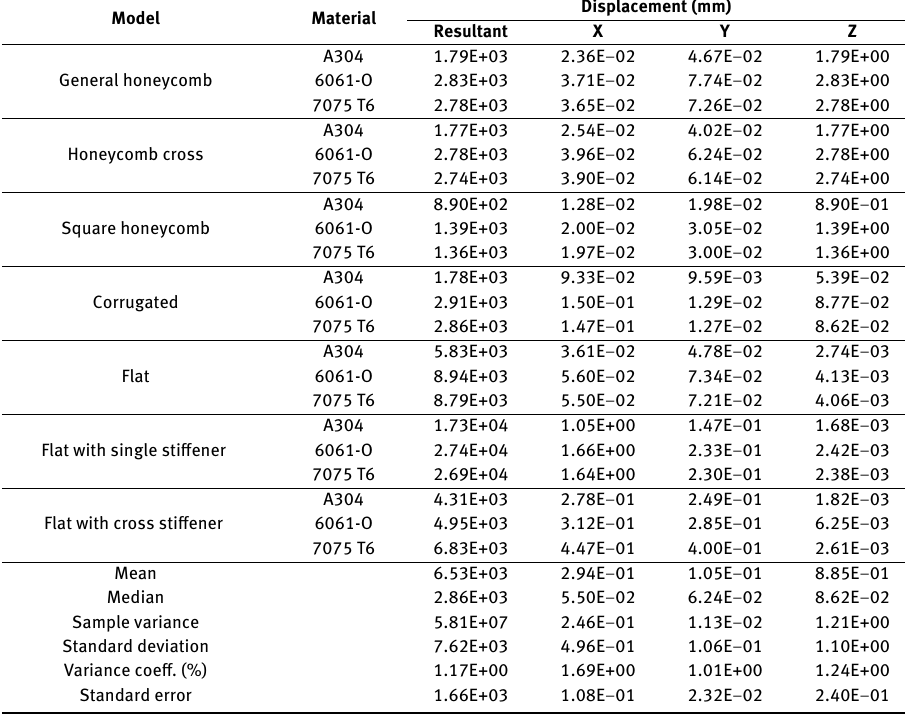
Table 4: Summary of the displacement